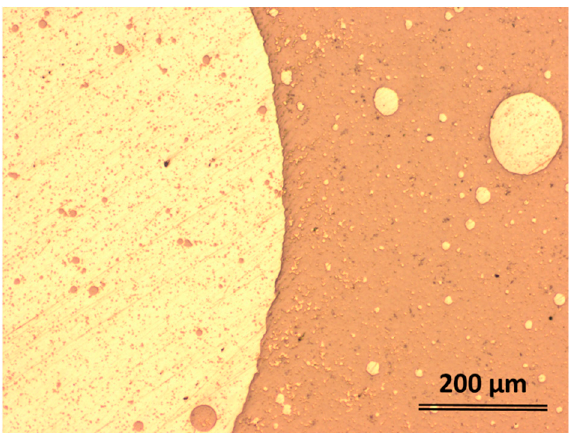
Figure 2. Optical micrographs showing the coarse separation from the liquid state. Centrifugal-cast rod with 5 mm diameter.